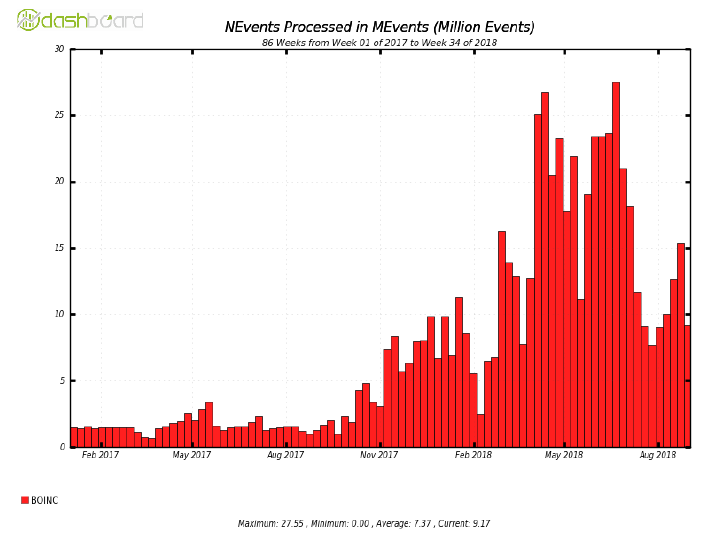
Figure 4. Simulation events processed per week from January 2017 to September